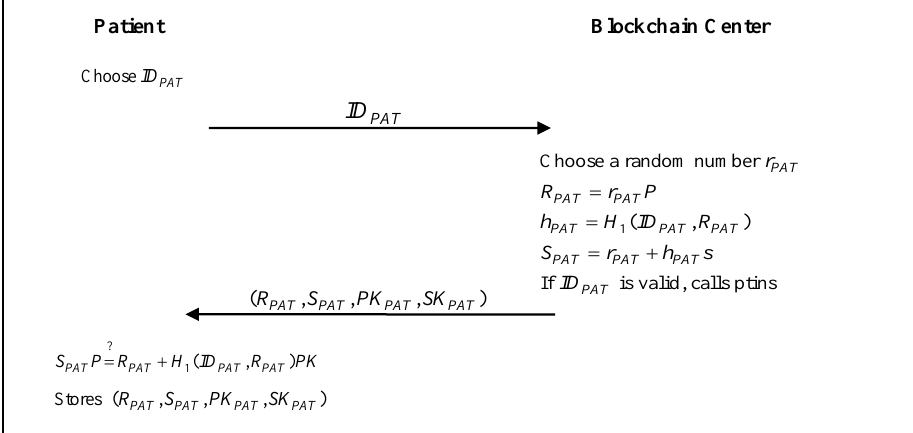
Figure 2. The patient registration phase of the proposed scheme.